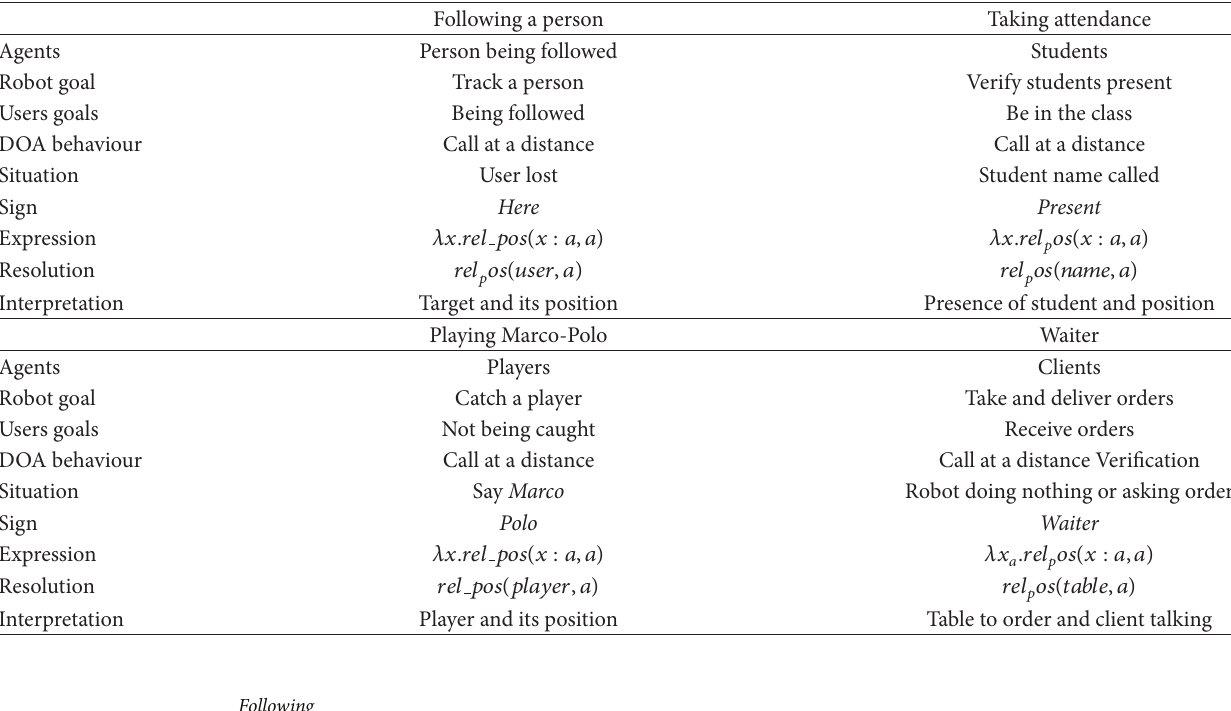
Table 4: Characteristics of the tasks using DOA behaviours.